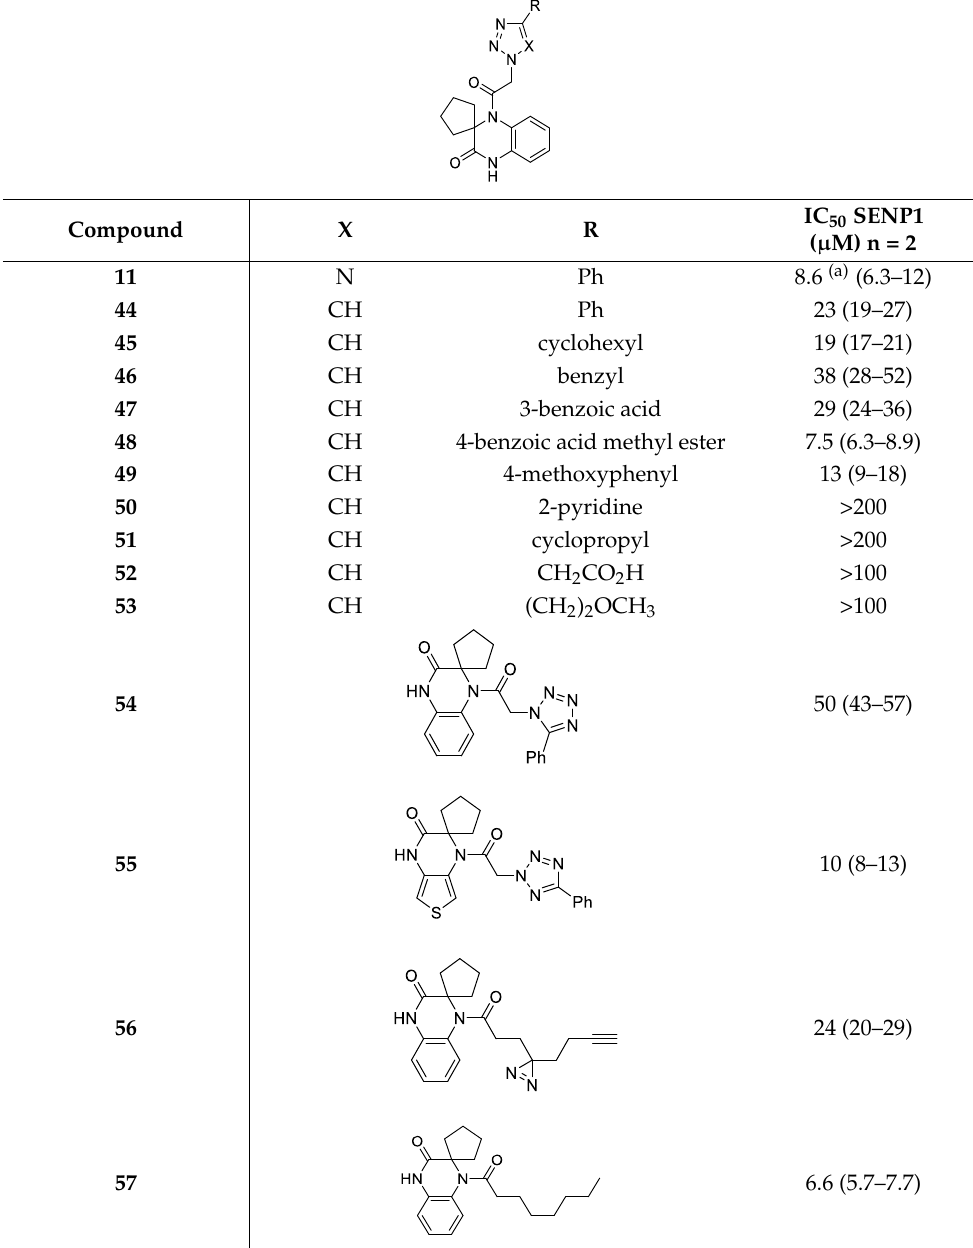
Table 3. IC 50 values of 11 and its analogues; (a) n = 5.